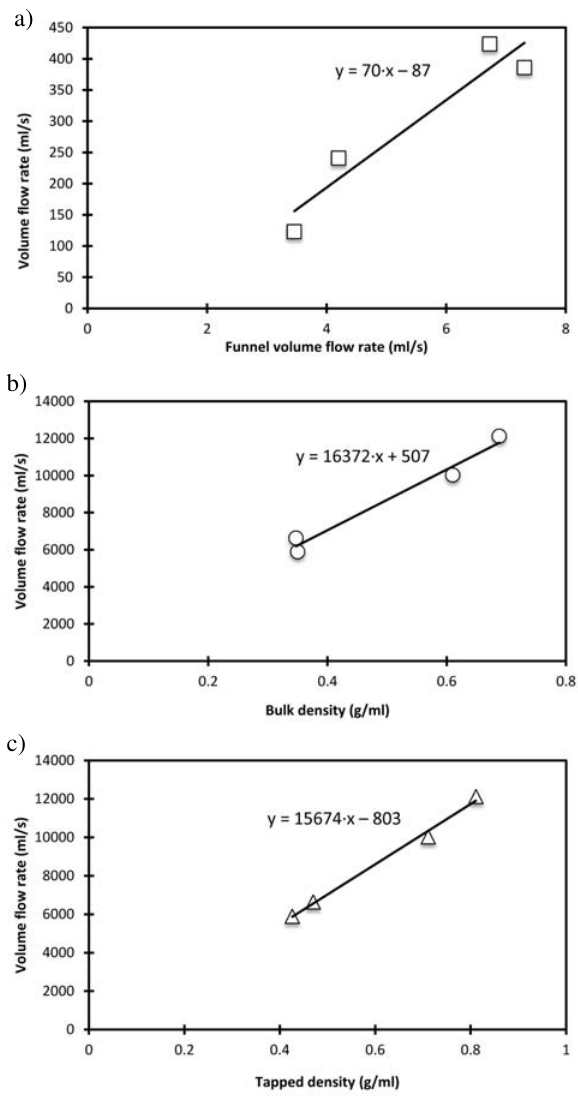
Figure 10: Linear correlations between powder volume flow rates (Table 4) and bulk powder properties (Table 7): closed outlet volu- me flow rate vs. funnel volume flow rate (top), open outlet pipe volume flow rate vs. bulk and tapped densities (middle and bot- tom). Only bulk powder properties with significant influence on volume powder flow are presented; linear correlation equations are